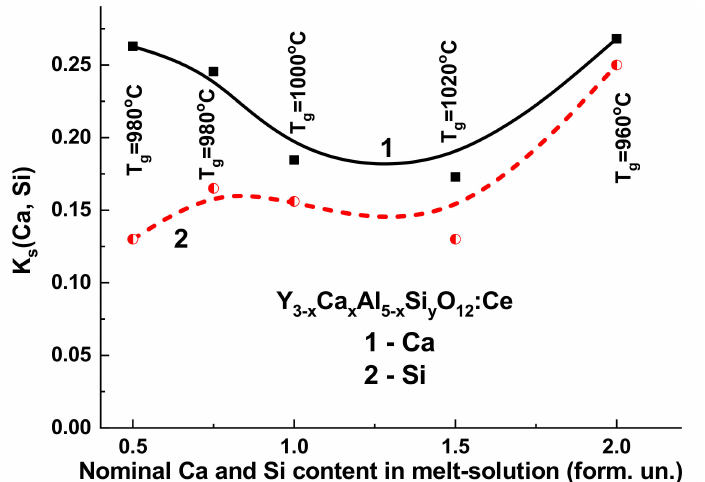
Figure 1. Photo of YAG substrate ( a ), as-grown Y 2.95 Ce 0.05 Al 5 O 12 :Ce ( b ), and Y 2.43 Ca 0.52 Ce 0.05 Al 4.5 Si 0.5 O 12 ( c ) SCFs (see also Table 1).